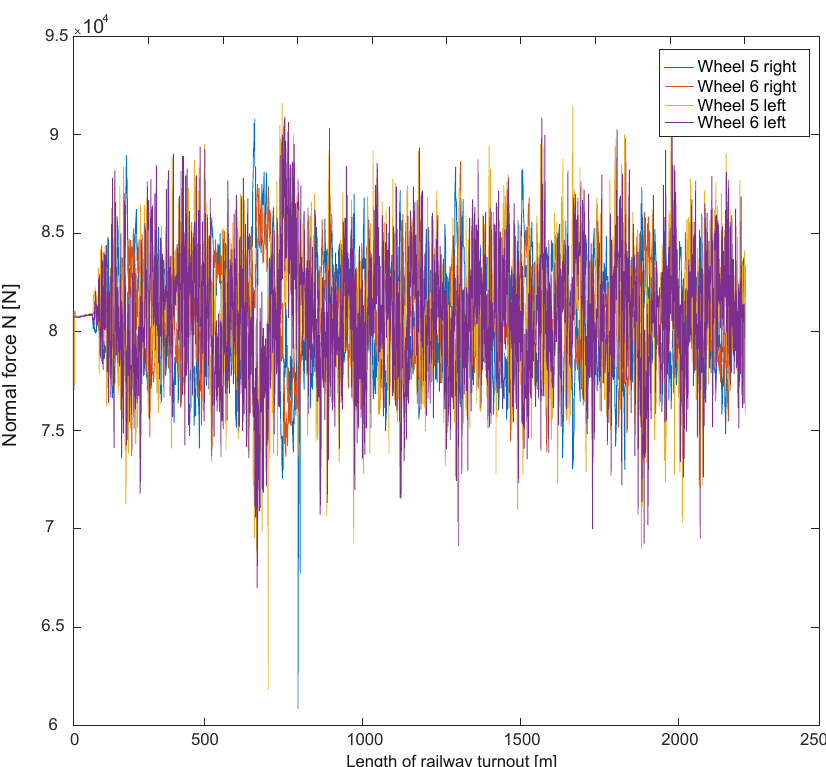
Figure 24 . Normal force at 250 km/h on a straight track without a turnout .